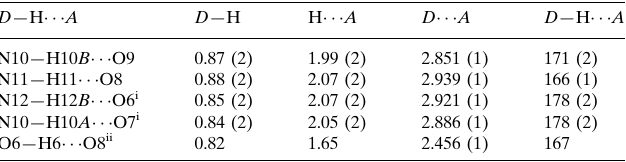
Hydrogen-bond geometry (A˚ , (cid:3)